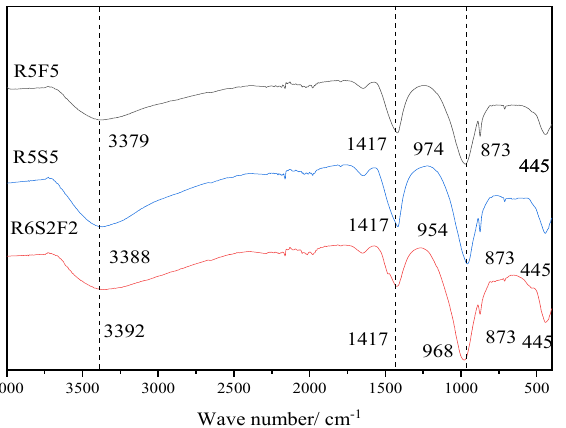
Figure 10. FTIR spectrum of AARCPC with different mineral admixtures content.